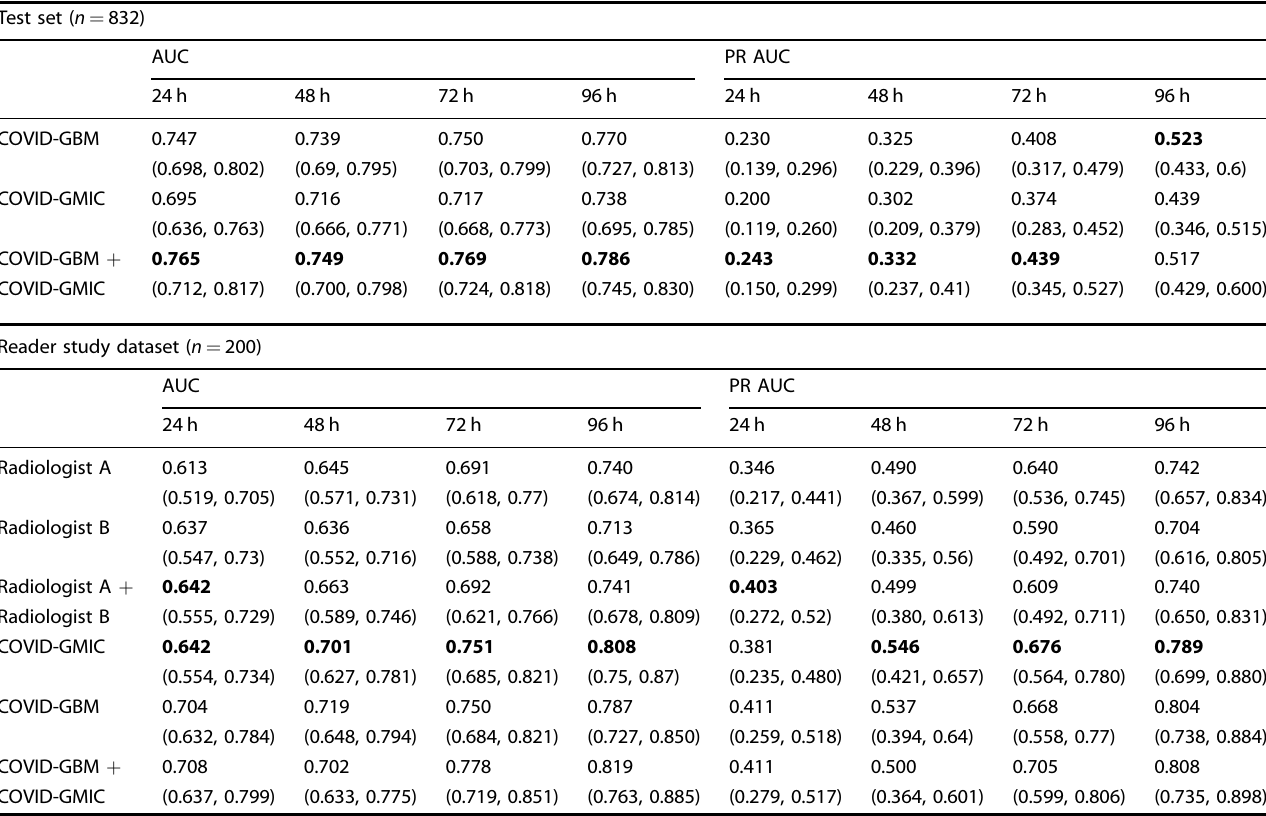
Table 2. Performance of the outcome classi fi cation task on the held-out test set, and on the subset of the test set used in the reader study ( n represents the number of